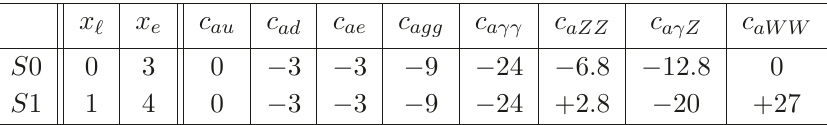
Table 1 . Values of the coefficients of the axion couplings to fermions and gauge boson field strengths in the physical basis for the two scenarios identified in eq. (2.12), where the normalisation is defined in eq.